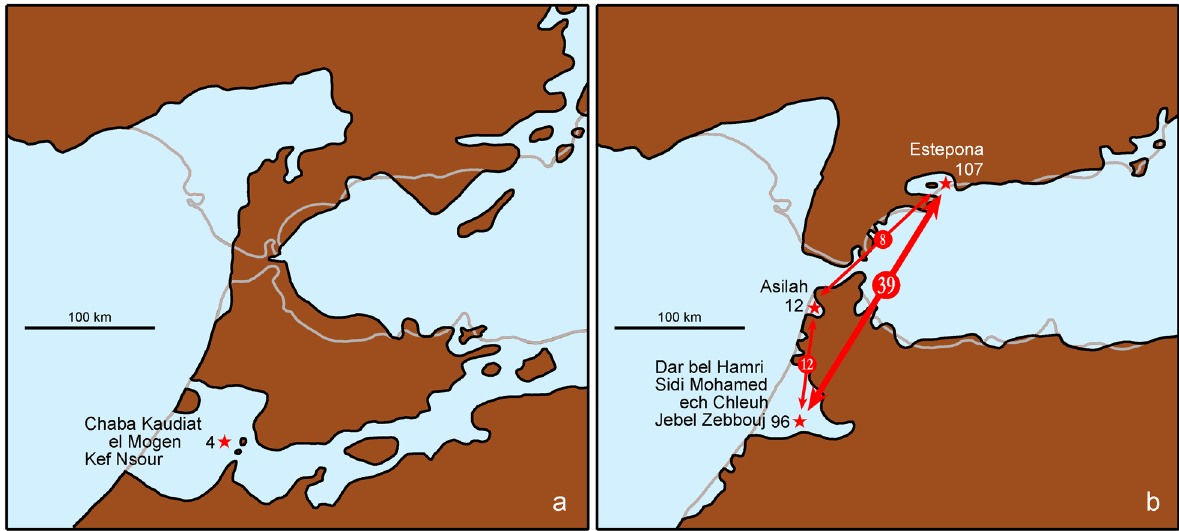
Fig. 29 Paleogeographic situation in northern Morocco and southern Spain during Messinian prior to the closure of the Mediterranean ( a ) and the Zanclean after opening of the Strait of Gibraltar ( b ), after Martin et al. (2014) and Pérez-Asensio (2021). Otolith-bearing localities are indicated by asterisks (Estepona from van Hinsbergh & Hoedemakers, 2022). Number of species at location in black printing; number of shared species on correlation